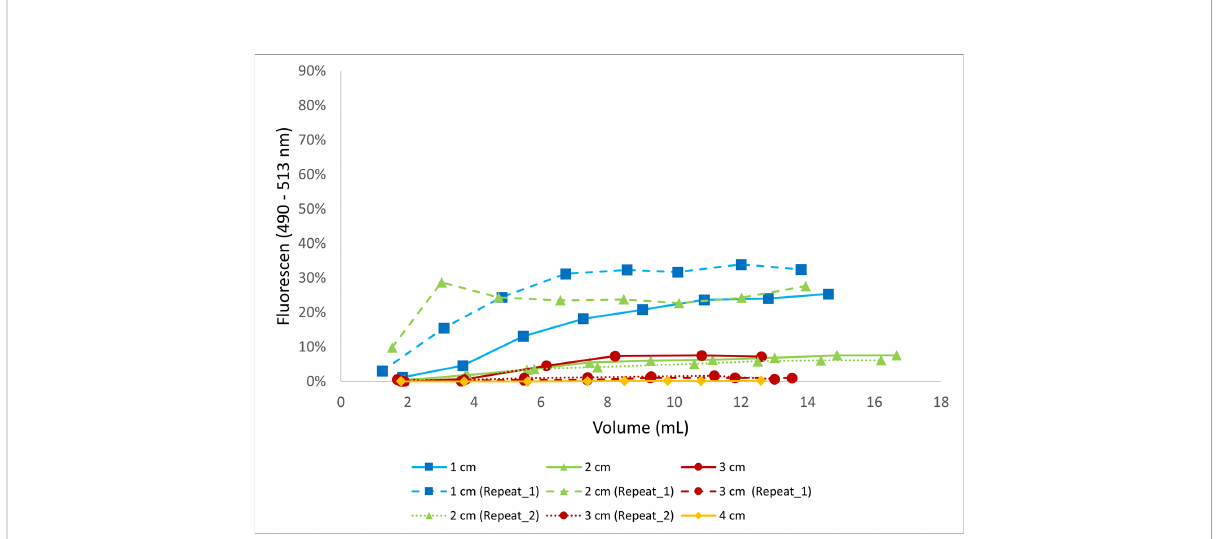
FIGURE 4 The proportion of fl uorescein (%) in the samples with reference to the fl uorescein in the overlying water as a function of the extracted volume of porewater through Rhizons from different depths. This experiment was conducted in the fi eld.